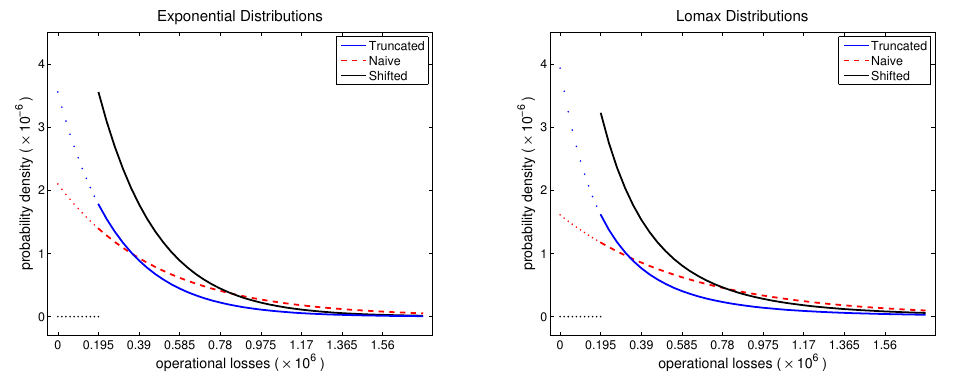
Figure 1. Truncated, naive, and shifted Exponential ( σ ) and Lomax ( α = 3.5, θ 1 ) probability density functions. Data collection threshold t = 195,000, with 50% of data unobserved. Parameters σ and θ 1 are chosen to match those in Tables 2 and 3 (see Section